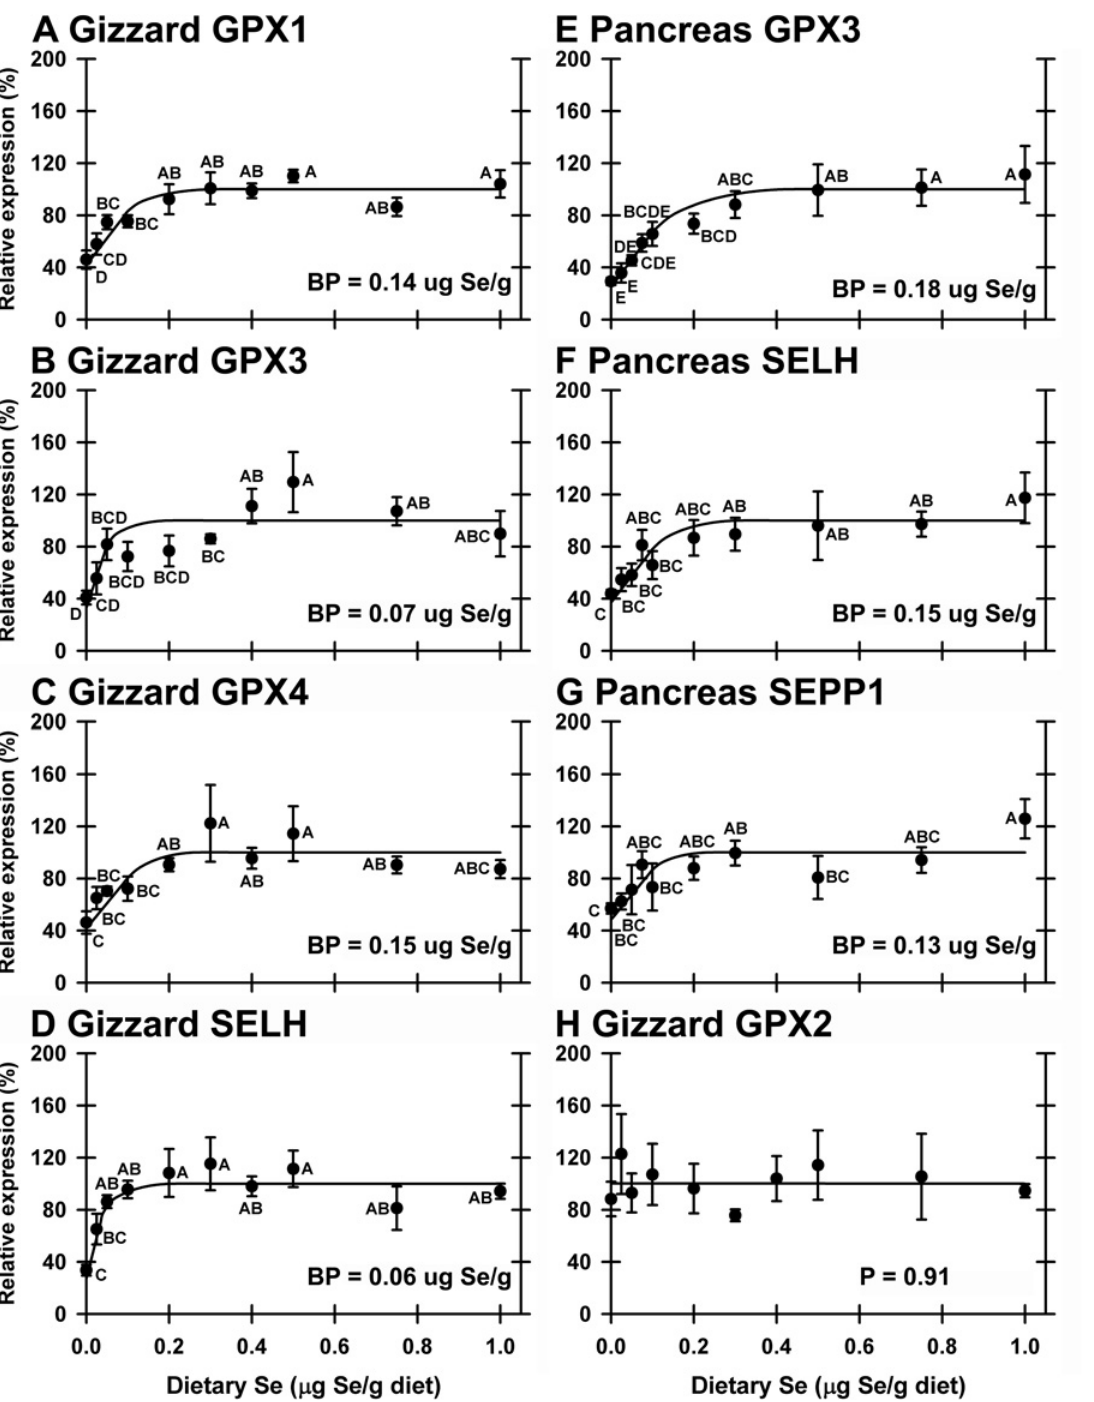
Fig 6. Effect of dietary Se on selenoprotein transcripts in gizzard (A-D, H) and pancreas (E-G). Relative transcript levels are plotted for gizzard GPX1 (A), gizzard GPX3 (B), gizzard GPX4 (C), gizzard SELH (D), pancreas GPX3 (E), pancreas SELH (F), pancreas SEPP1 (G) and gizzard GPX2 (H) in poults supplemented with graded levels of dietary Se for 28 d. Means without a common letter are significantly different ( P < 0.05). BP calculated as described in text. Gizzard GPX2 is displayed as example of an unregulated gene. Overall level of significance given in Table